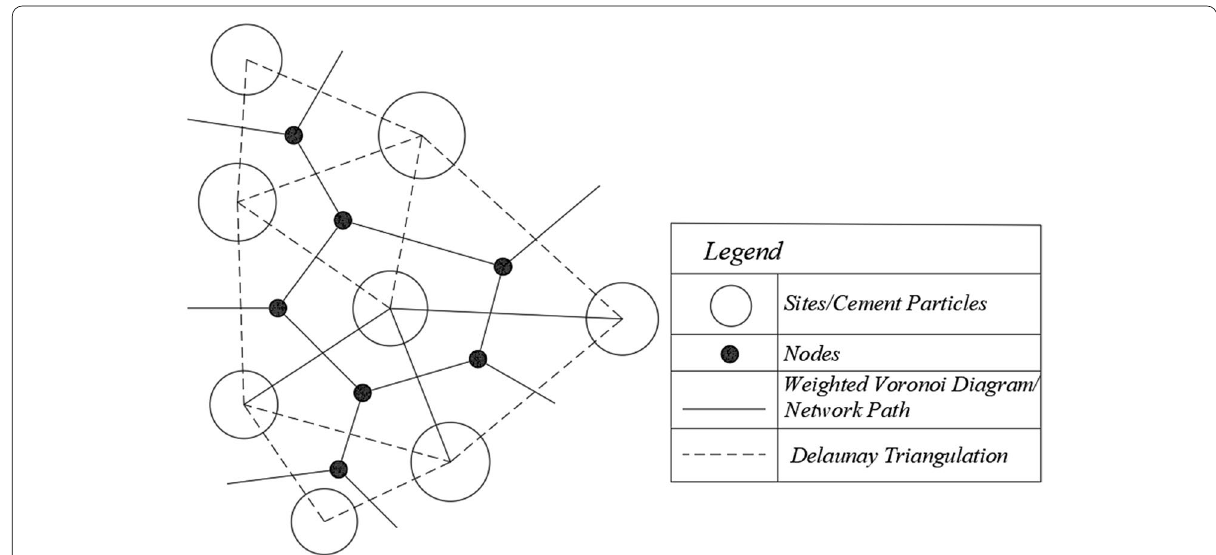
Fig. 7 Schematic diagram of network node connection.